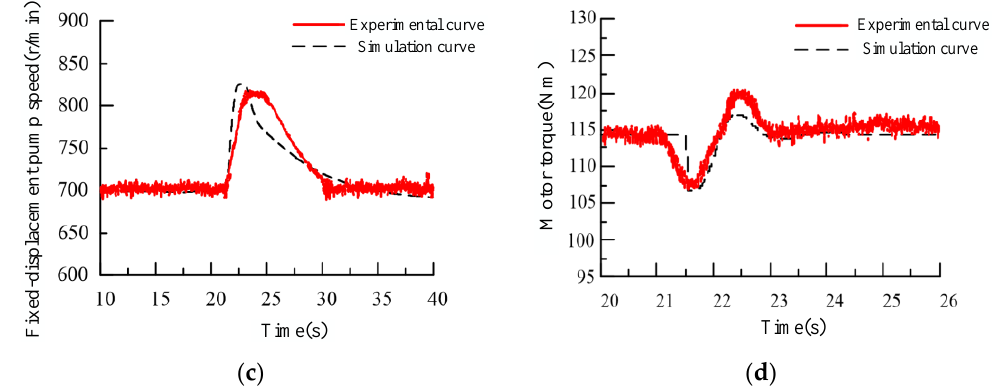
Figure 14. Curves for grid voltage three-phase drop of 20%. ( a ) HWT output power test curve; ( b ) System pressure test curve; ( c ) Fixed-displacement pump speed test curve; ( d ) Motor torque test curve.